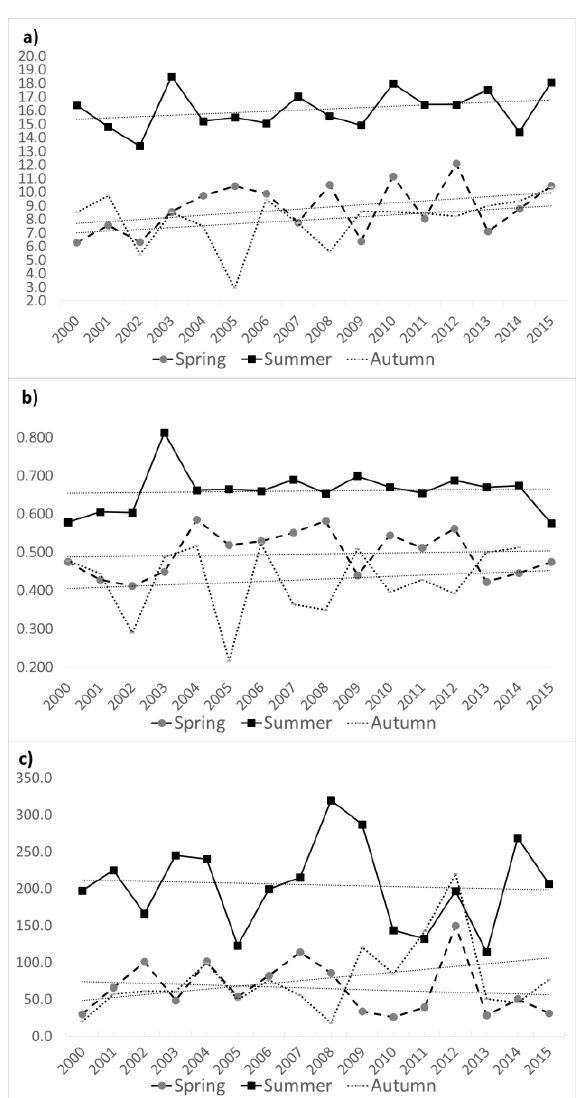
Figure 3. Trend graphs of the averaged surface air temperature (a), NDVI (b) and precipitation sums (c) for the 2000-2015 period. The trends produced for the Syktyvkar meteorological station data using NDWI-based allocation of the growing season